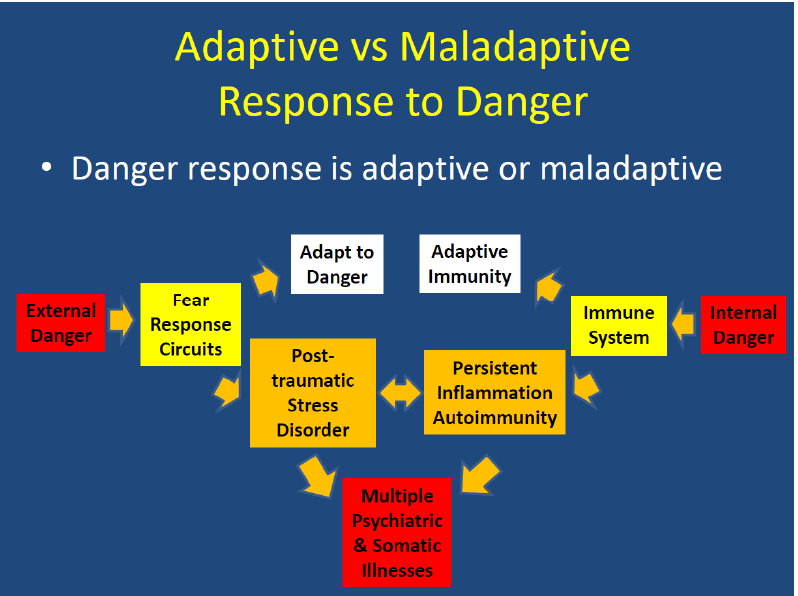
Figure 2. Adaptive vs. Maladaptive Response to Danger.